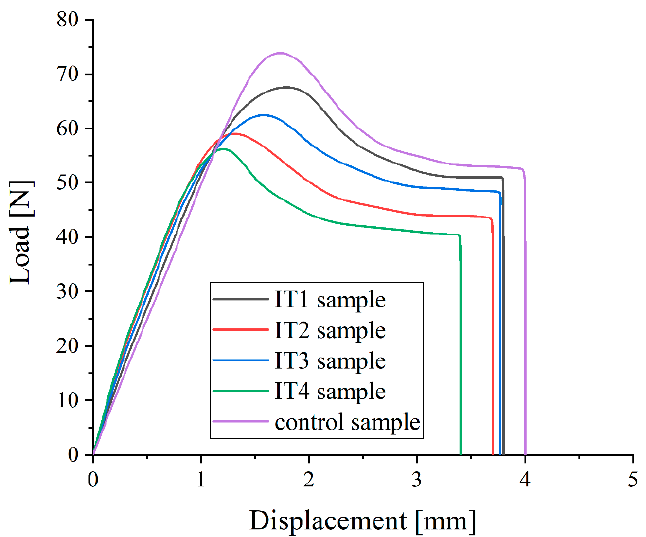
Figure 13. Small punch test load-displacement curves for the control and retrieved UHMWPE samples.